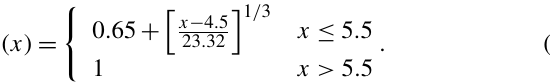
(legend at the top right corner). The dashed black line is the linear hub